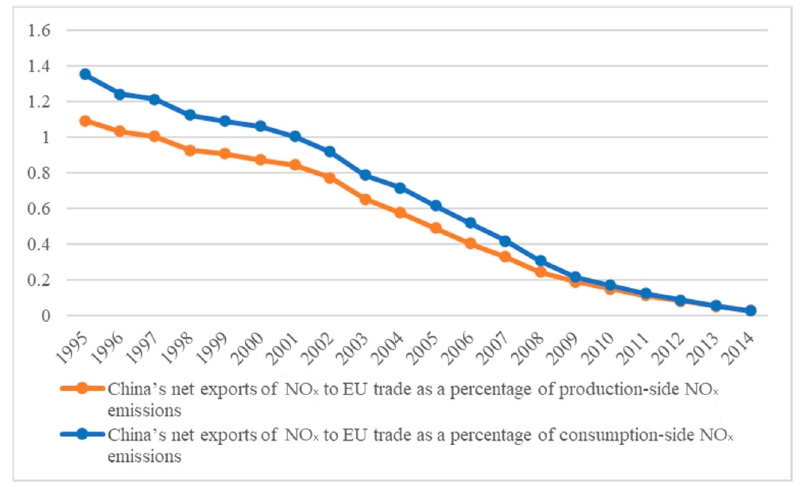
Figure 3. Percentage of China’s net exports of NOx in trade with the EU.